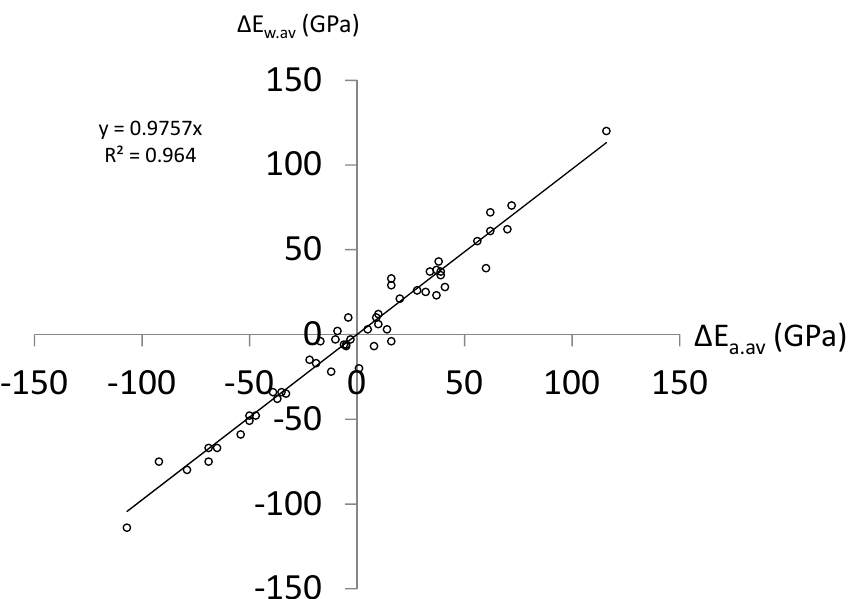
Figure 9. Arithmetic average value ( Δ E a.av ) and weighted average value ( Δ E w.av ) of the difference in the inherent Young’s modulus between a grain and its adjacent grains.